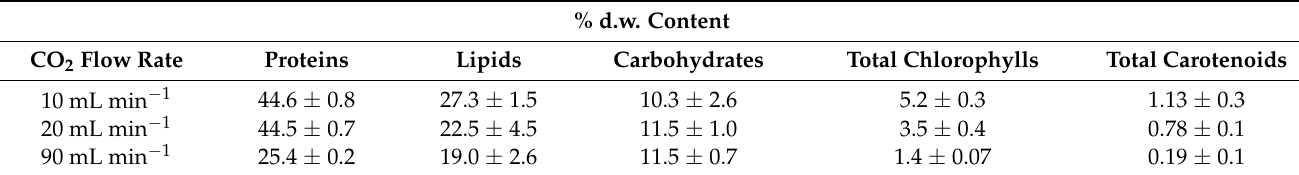
Table 15. Effect of CO 2 on biomass biochemical composition. % d.w.